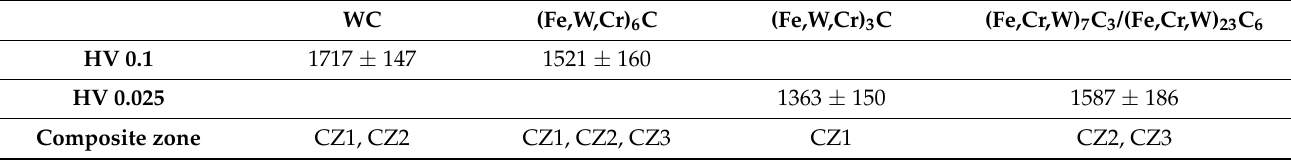
Table 1. Hardness of the precipitated carbides in the composite zones.